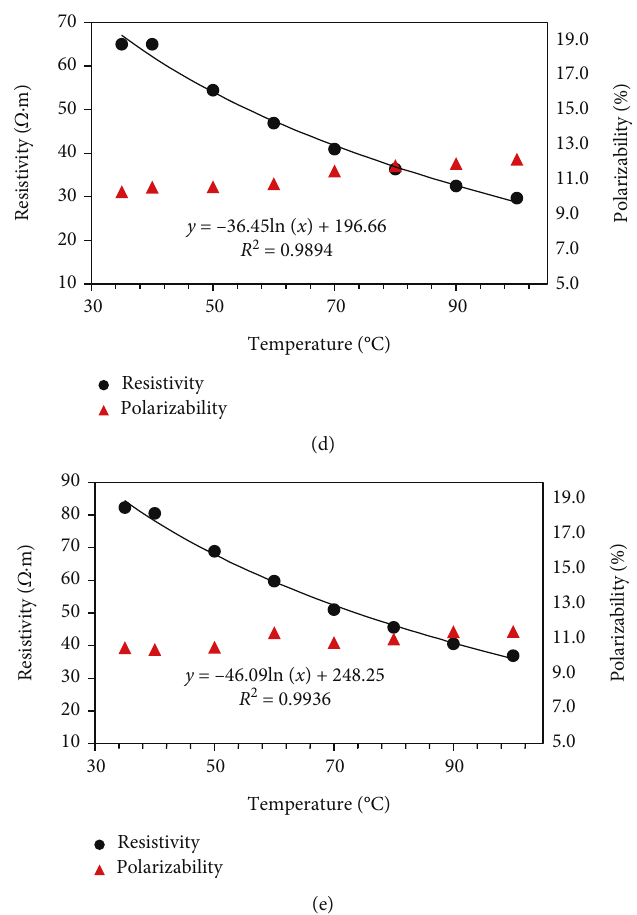
Figure 10: (a – e) The inversion results of the complex resistivity for samples 1, 2, 3, 4, and 5 under di ff erent temperature conditions,